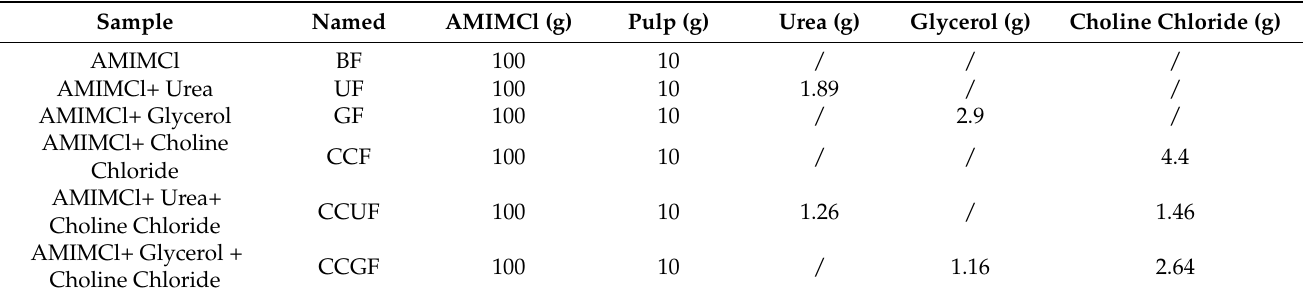
Table 1. Dosages of chemicals used in the regenerated cellulose fiber-making